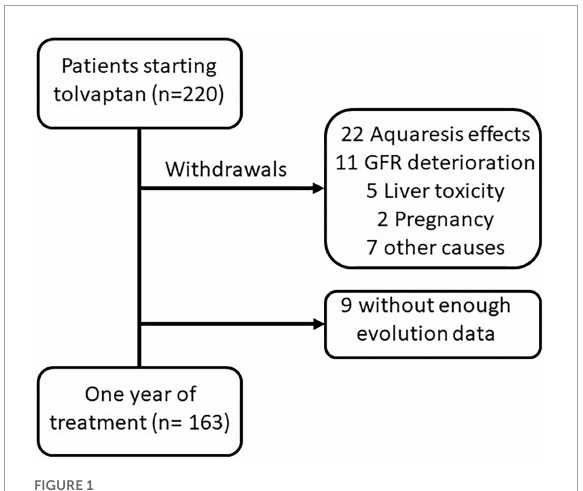
FIGURE1 Flow chart of patients who started treatment with tolvaptan.